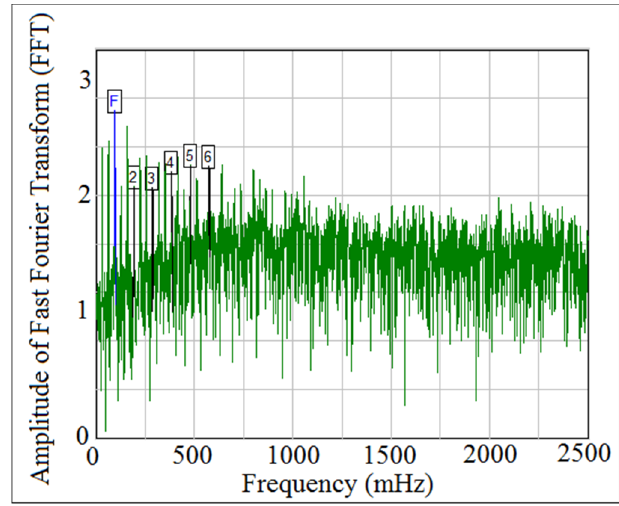
Figure 24. Power density function of the experiment test.